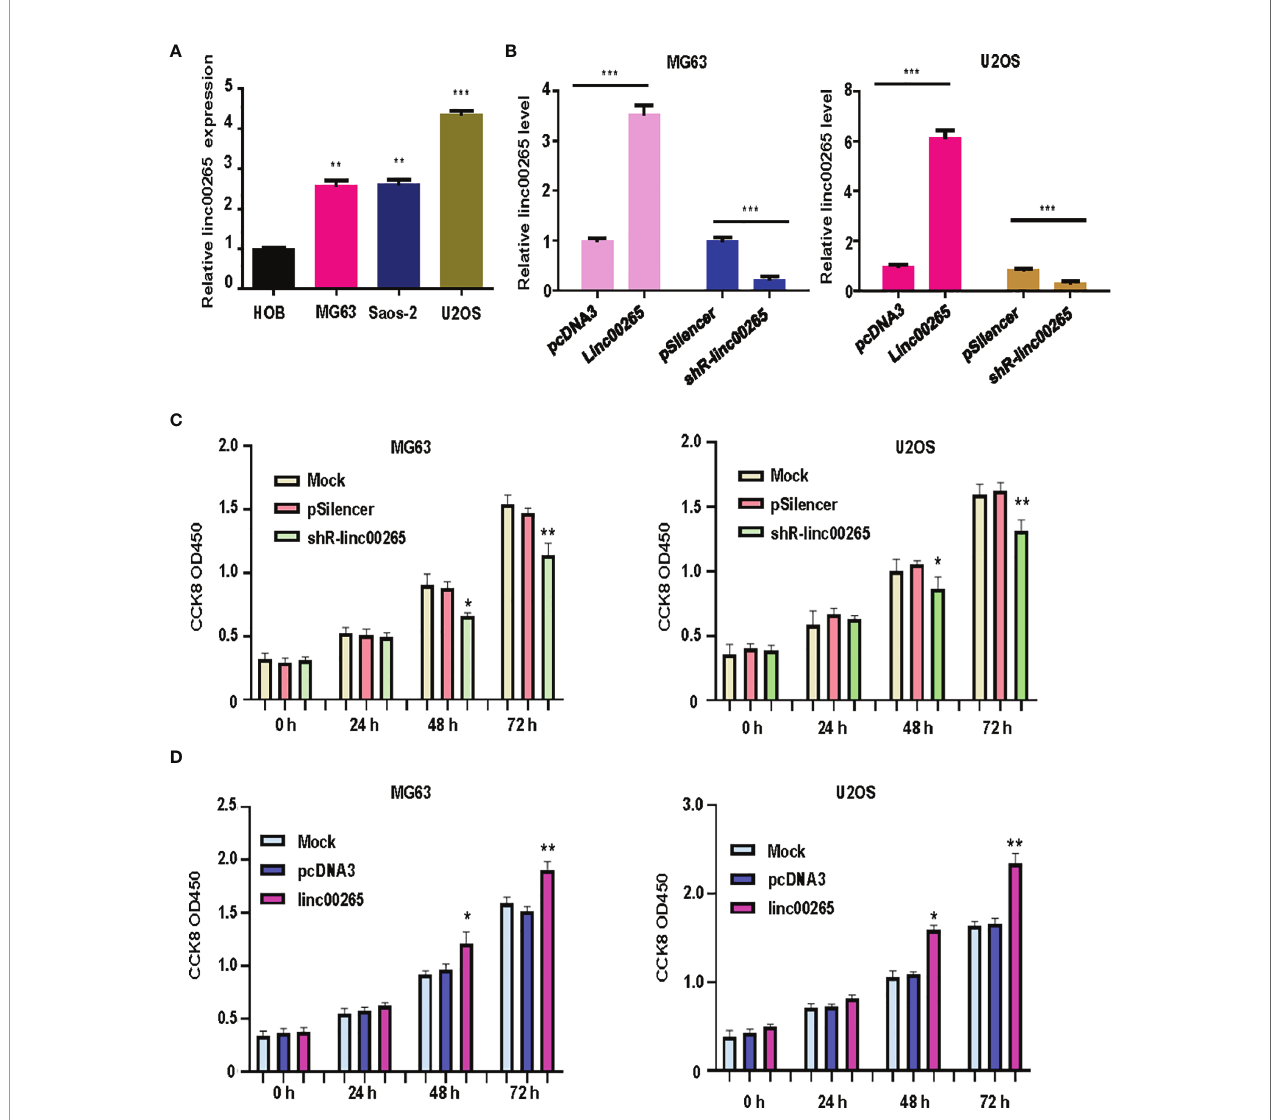
FIGURE 1 | Linc00265 overexpression promotes viability of osteosarcoma cells. (A) Real-time RT-PCR was utilized to examine the expression levels of linc00265 in HOB cells and three osteosarcoma cell lines, including MG63, SaOS-2 and U2OS. (B) Real-time RT-PCR was performed to examine linc00265 expression levels in MG63 and U2OS cells after various plasmid transfections. (C) CCK-8 assay was conducted to detect the viability of osteosarcoma cells after linc00265 knockdown for 24 h, 48 h, and 72 h. (D) CCK-8 assay was utilized to detect the cell viability in linc00265-overexpressing osteosarcoma cells for 24 h, 48 h, and 72 h. * P < 0.05, ** P < 0.01, *** P < 0.001 vs.